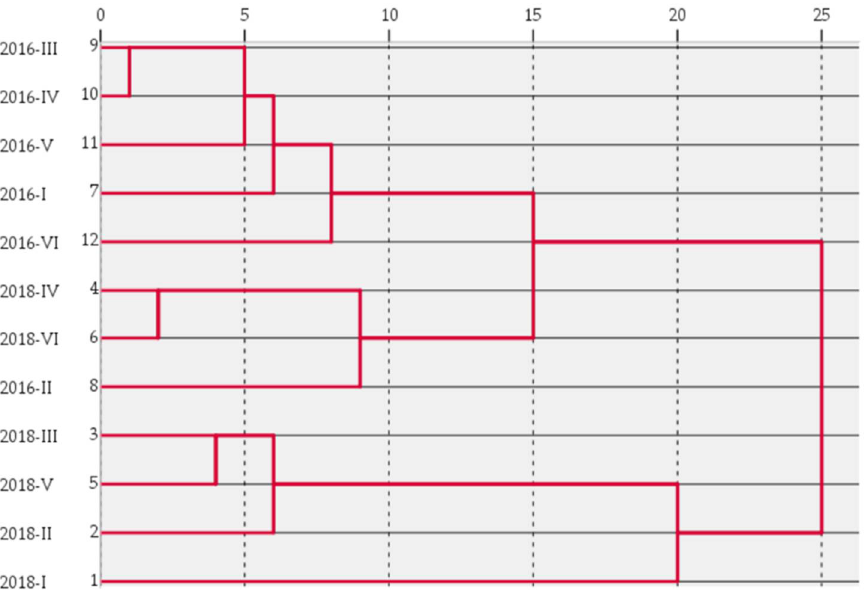
Figure 3. Hierarchical cluster analysis of the soil fertility of different forest types.